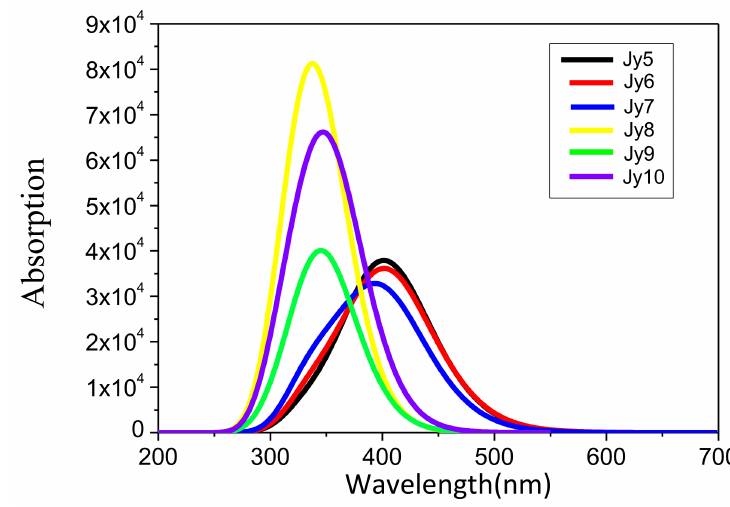
Figure 6. UV-Vis absorption spectra of six investigated molecules in